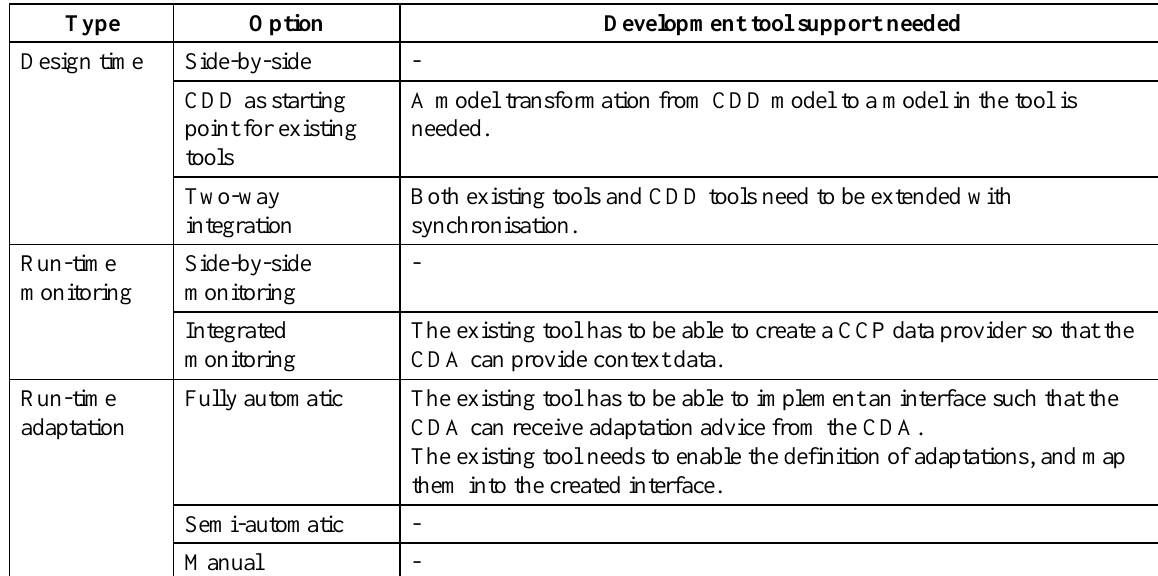
Table 6. Summary of integration